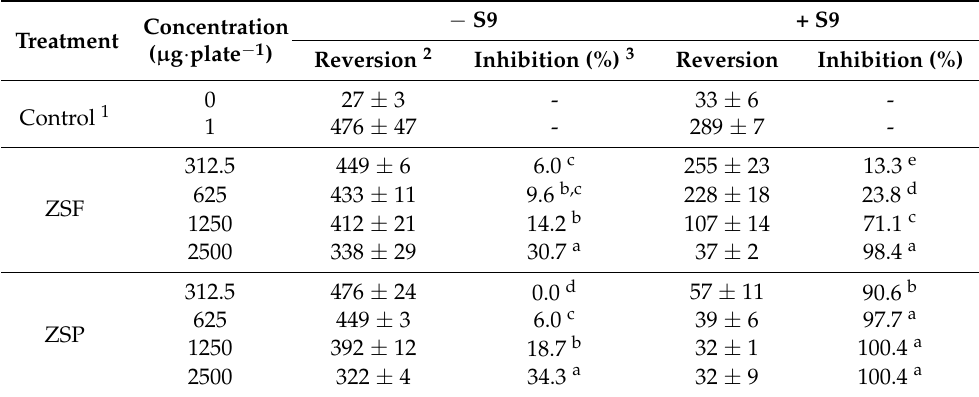
Table 2. Antimutagenic effects of Zanthoxylum schinifolium extracts against mutagens in Salmonella typhimurium TA98, with or without the S9 mix.